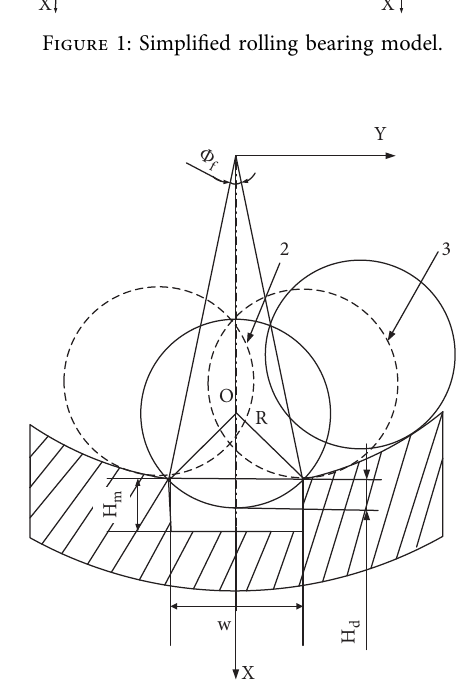
Figure 2: Process of roller passing defect.